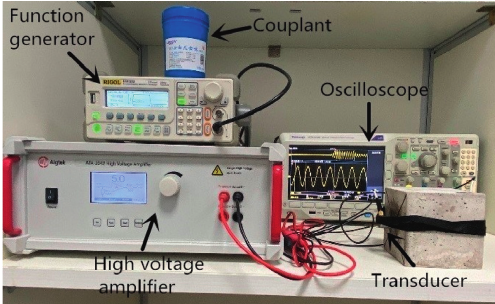
Figure 13: Test system for signal generation and acquisition.